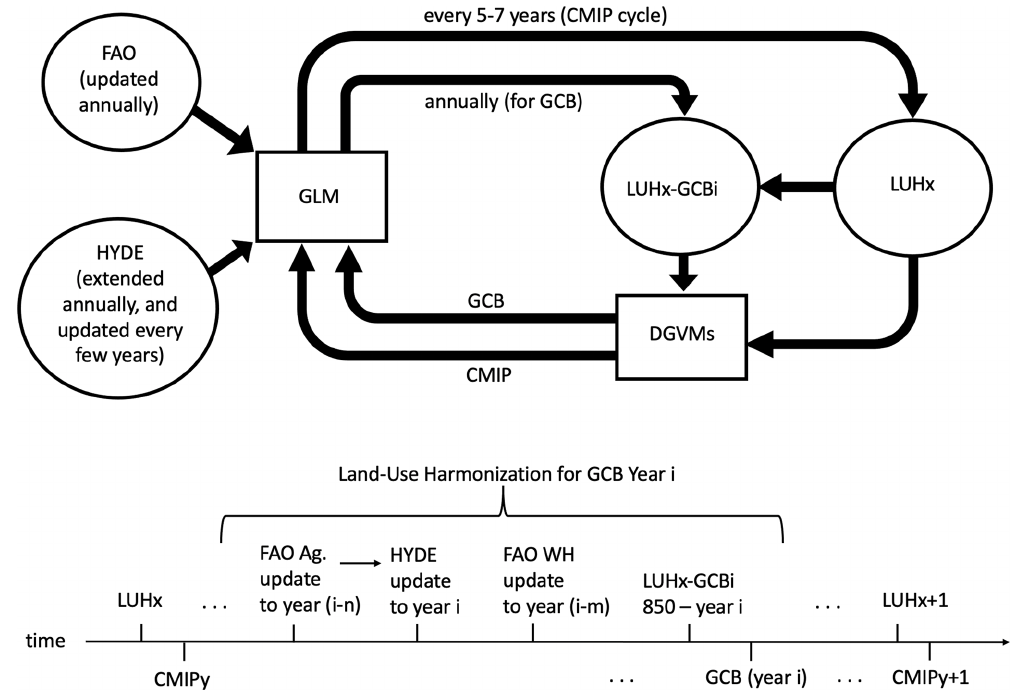
Figure 1. (a) Schematic diagram of LUH-GCB annual updates showing interactions and dependencies between core LUH products, LUH- GCB datasets, and annually updated inputs. (b) Timeline of LUH-GCB annual updates illustrating the sequence of dataset updates and associated latencies that occurred during the creation of a generalized LUHx-GCBi dataset. Table 1. Input datasets and simulation years for annual LUH-GCB datasets and core LUH